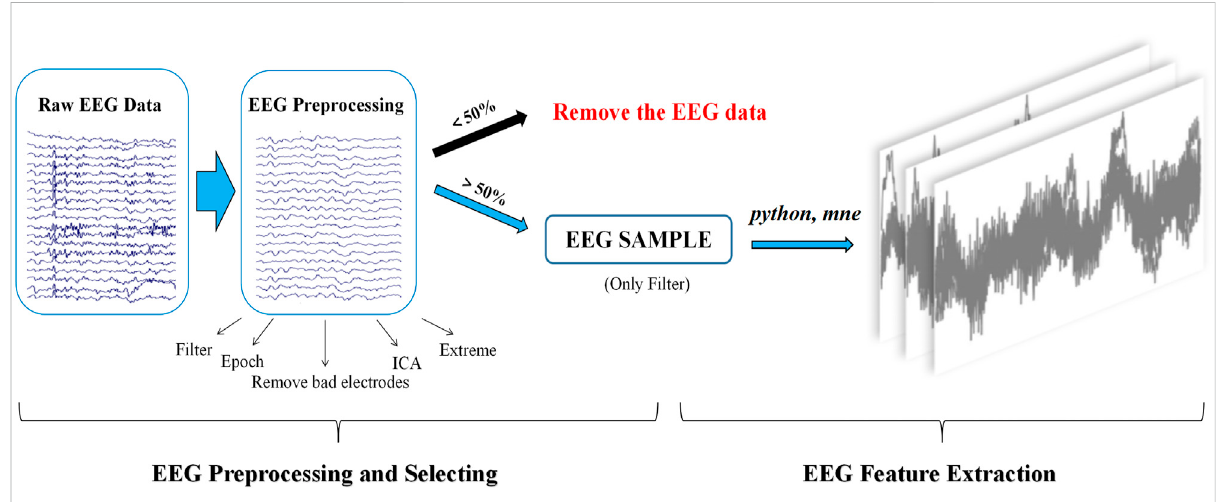
FIGURE 2 Block diagram for EEG preprocessing, selecting, and feature extraction.